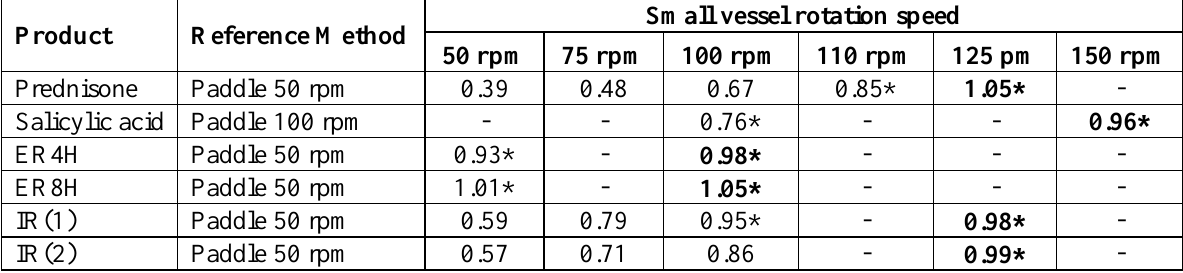
Table 3. Mean of ratio ( Ө ) percent dissolved between small and one liter dissolution at mean different rotation speeds. Best values are in